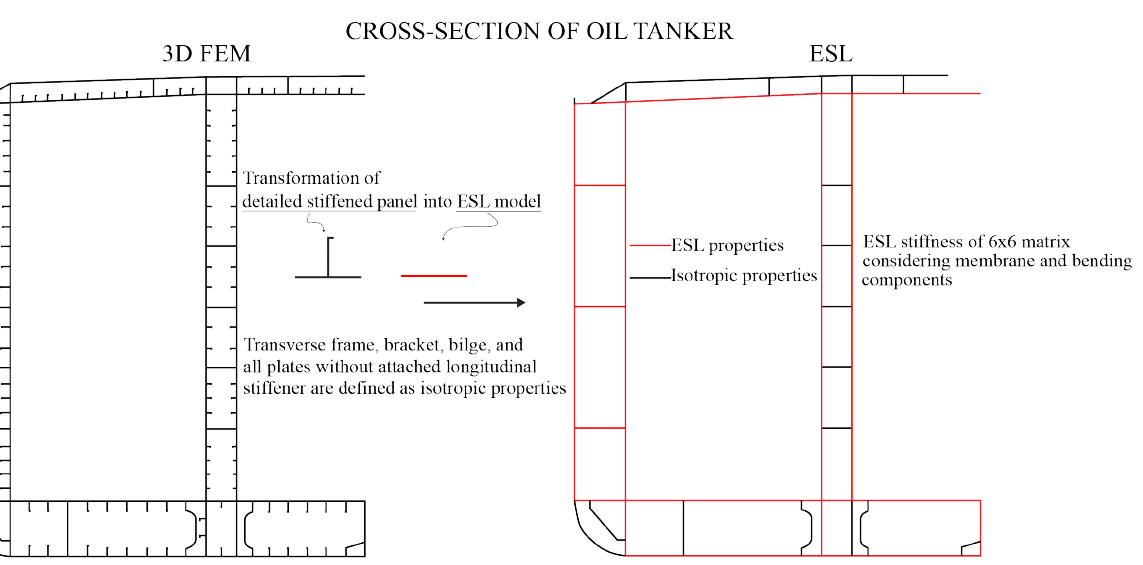
Figure 3. Application of ESL in a ship’s hull